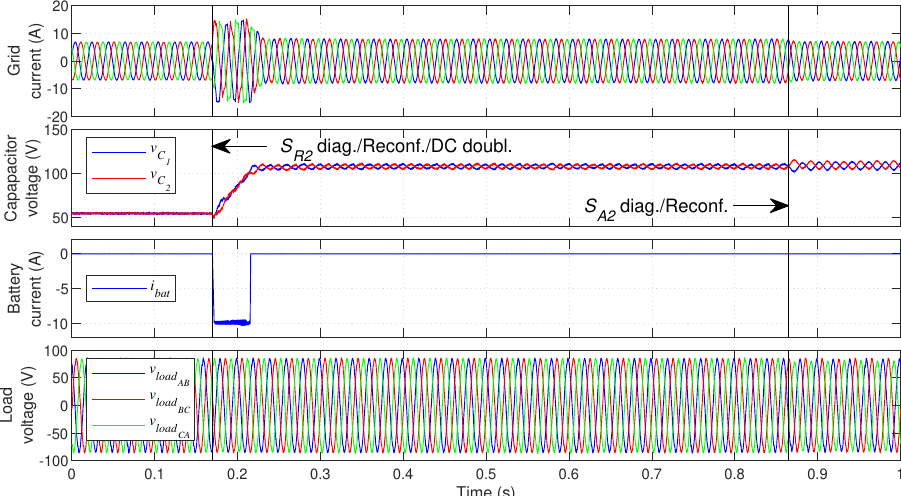
Figure 26. Normal and fault-tolerant UPS operation when OC faults occur in IGBTs S R 2 and S B 2 of the grid-side and load-side